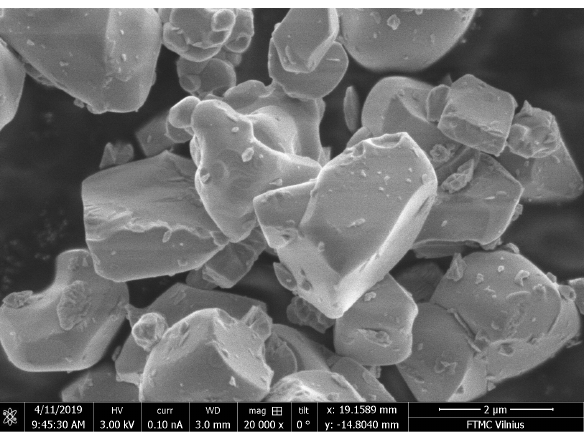
Figure 1. Scanning electron microscopy of the 0.7Pb(Mg 1/3 Nb 2/3 )O 3 -0.3PbTiO 3